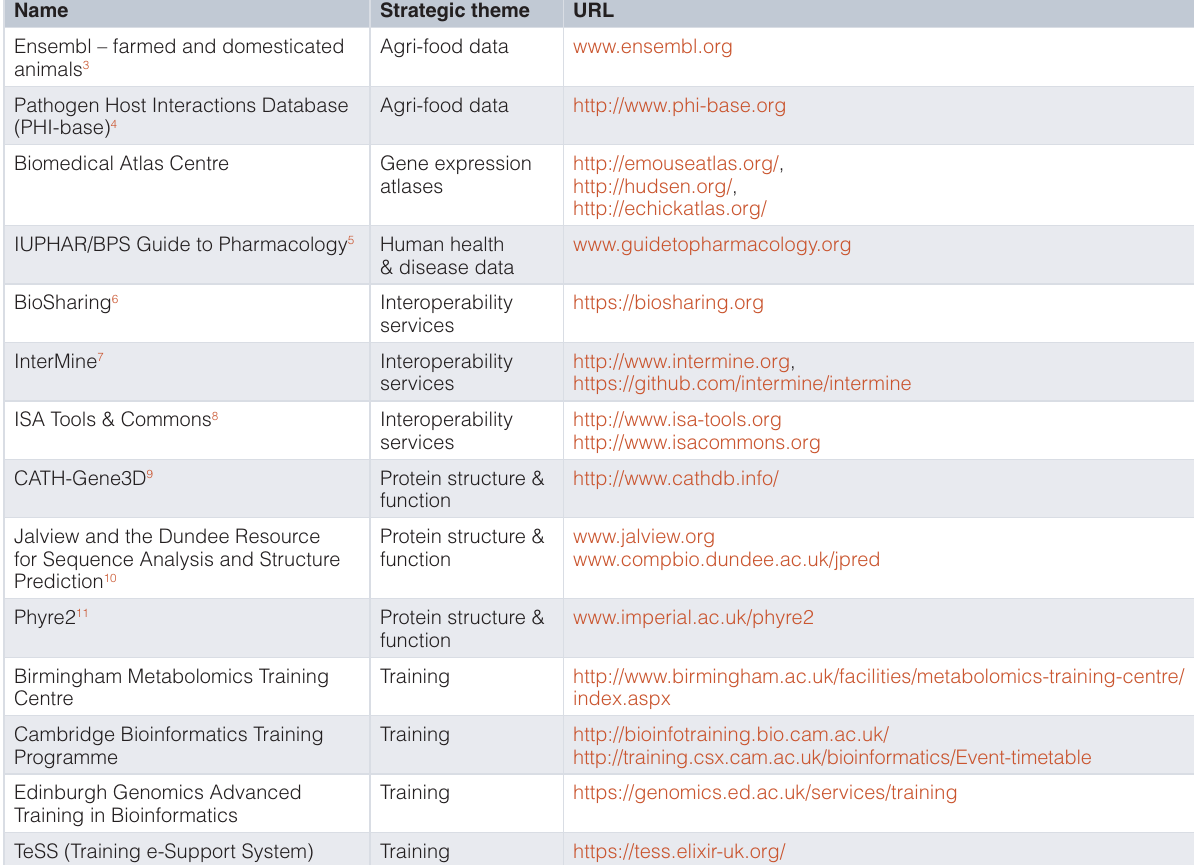
Table 3. Resources judged to be ready for inclusion in ELIXIR at the end of the assessment process. Resources are classified by strategic themes within